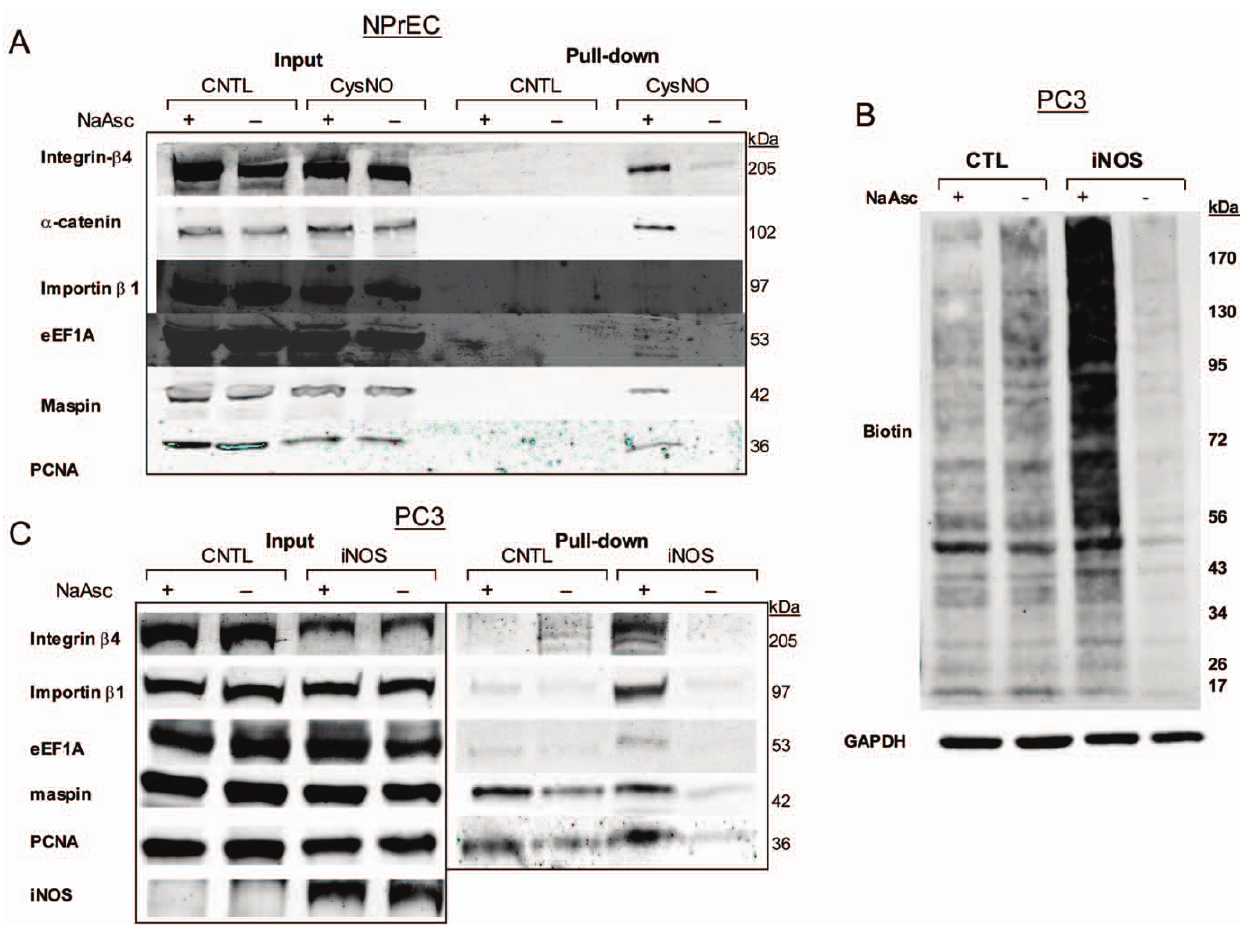
Figure 4. Verification of nitrosylated proteins. A ) Western blot analysis of targets nitrosylated by CysNO. NPrEC were treated with 1 mM CysNO, and 1 mg of protein extract was subjected to BST. Biotinylated proteins were pulled down with Neutravidin beads, eluted with b - mercaptoethanol, concentrated and detected using western blot. 8% of total protein was loaded as input, and the same membrane was probed with respective antibodies with stripping and re-probing. B ) Protein nitrosylation in iNOS expressing PC3 cells. PC3 cells were transiently transfected with an iNOS expressing plasmid. Cells were harvested 24 h post-transfection. 3.5 mg of total protein was subjected to BST, as described in Materials and Methods. After BST, the overall protein nitrosylation was assessed by western blot using an anti-biotin antibody. The membrane was stripped and re-probed with GAPDH to show equal loading. C ). Endogenous nitrosylation of protein targets. Biotinylated proteins were pulled down with Neutravidin and analyzed by Western blot. Seventy m g was loaded as input, and the same membrane was probed with respective antibodies with stripping and re-probing.